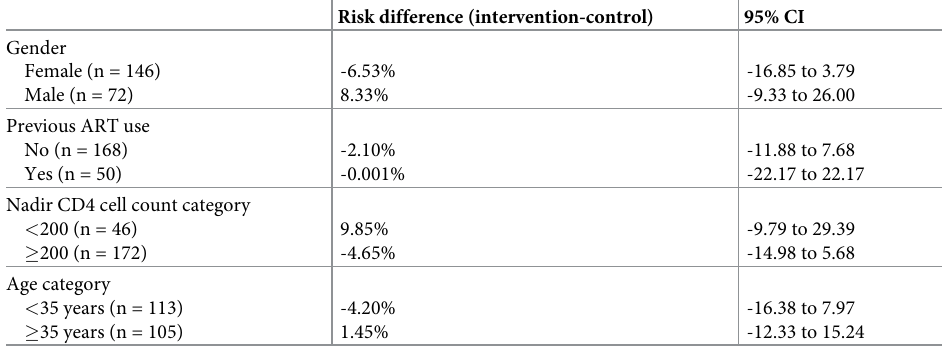
Table 4. Results of additive binomial models examining the association between trial arm and primary outcome (VL < 400 copies/mL) in a priori subgroups of demographic and clinical characteristics (unadjusted).